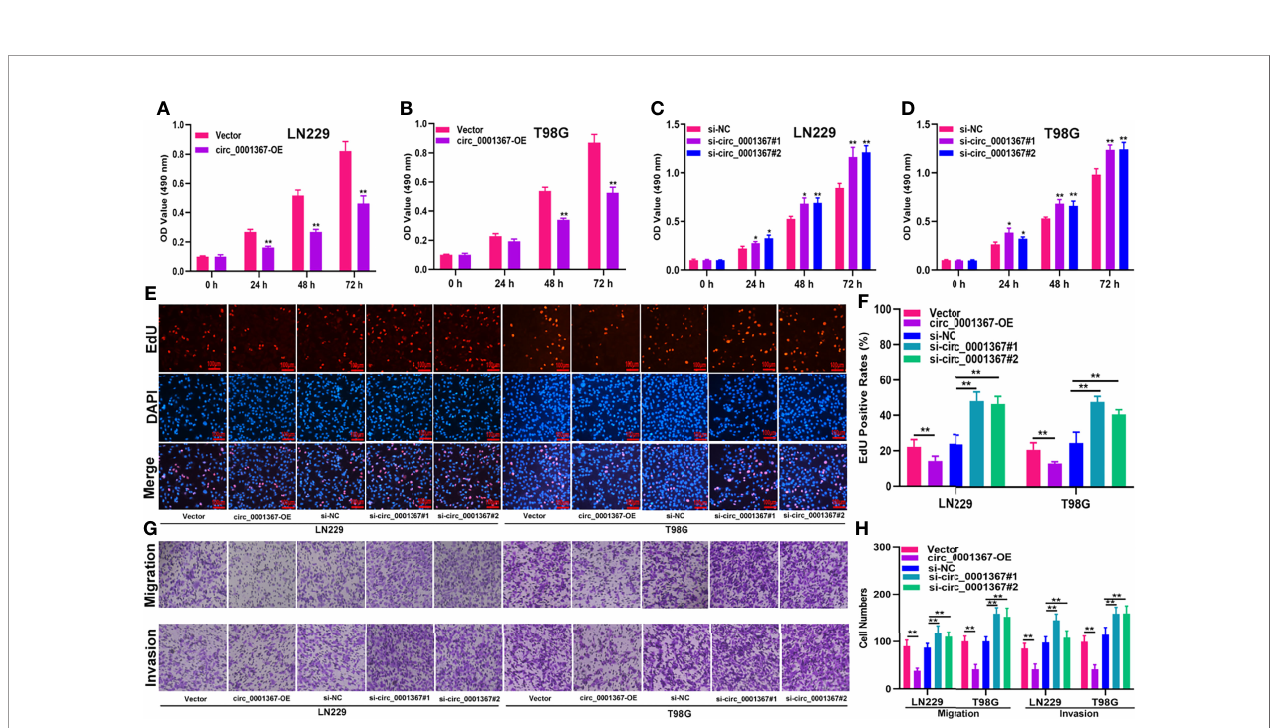
FIGURE 2 | Hsa_circ_0001367 inhibits the proliferation, migration and invasion of glioma cells. (A – D) The effect of circ_0001367 on cell viability in T98G and LN229 cells was assessed with MTT assays. (E, F) EdU assays were used to evaluate the effect of circ_0001367 on the proliferation of T98G and LN229 cells. (G, H) Transwell assays were performed to analyse the effects of circ_0001367 on the migration and invasion of T98G and LN229 cells. *P < 0.05, **P <